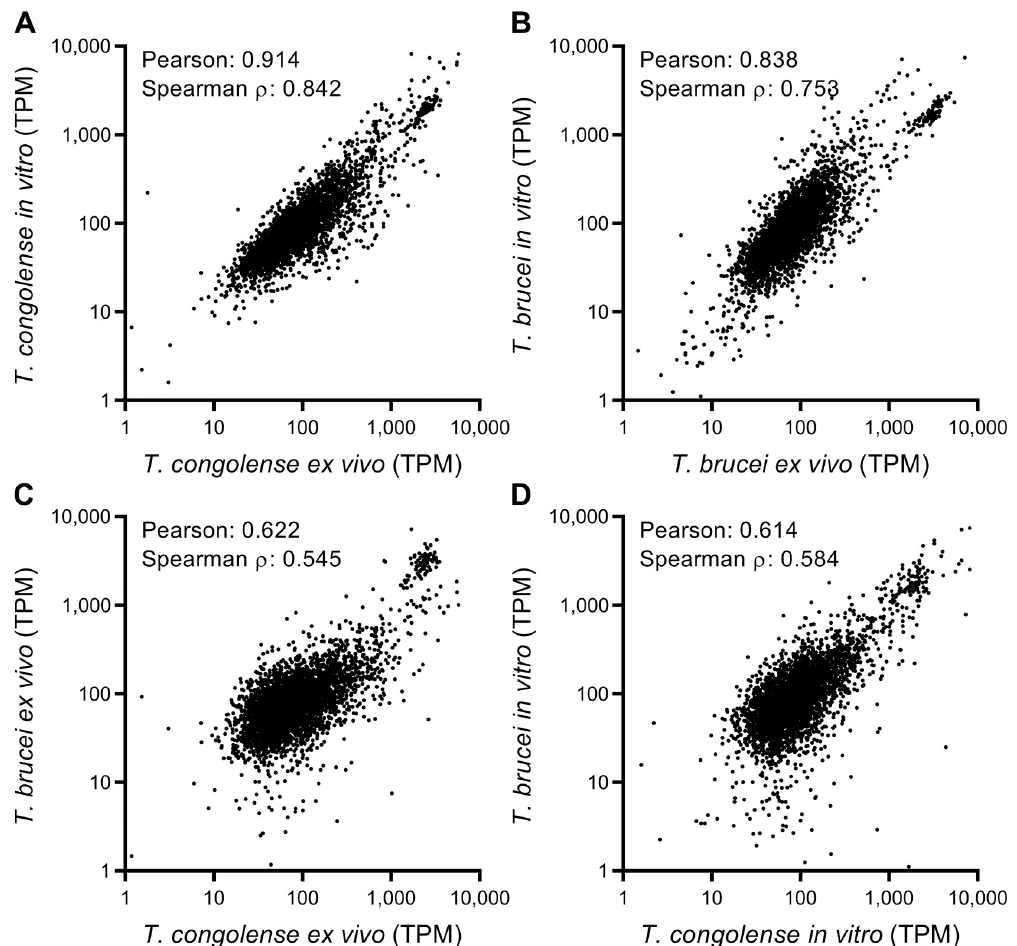
Fig 1. Overview of comparative transcriptomics analysis of T . brucei and T . congolense , isolated from ex vivo and in vitro conditions. RNAseq data from T . congolense (IL3000) and T . brucei (STIB 247) in both in vitro and ex vivo (from mouse infections) conditions were aligned to the species’ respective reference genomes and read counts were normalised by the transcripts per million (TPM) method. To directly compare the species, a pseudogenome was generated using the Orthofinder tool [57]. TPM values from the 4 sample groups were plotted against each other to analyse correlation between conditions (A and B) and between species in the same conditions (C and D). Correlation was assessed using both Pearson correlation (Pearson’s r ) and Spearman’s rank correlation